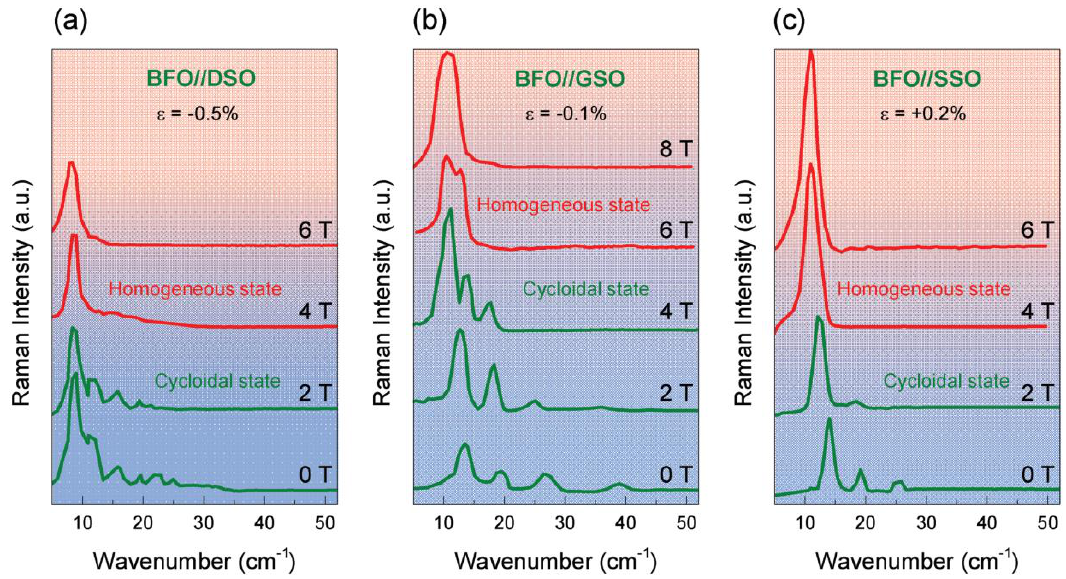
Figure 4. Low-energy Raman fingerprint of spin cycloid at 295 K of BFO grown on ( a ) DyScO 3 , ( b ) GdScO 3 and ( c ) SmScO 3, respectively. The magnetic field was applied normally to the film plane as seen in Reference [3].